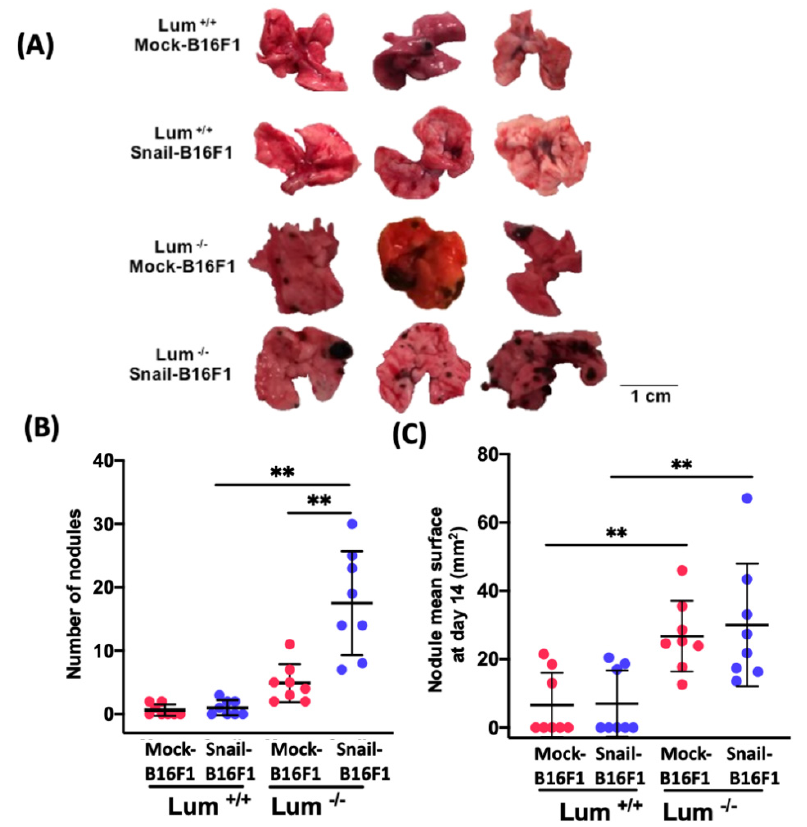
Figure 1. Study of lung metastatic nodules of melanoma cells in the wild-type and lumican-knockout C57BL/6J mice. ( A ) Lung metastatic nodules, observed at day 14, obtained after injection in the tail vein (n = 250.000 cells/mouse) of Mock-B16F1 and Snail-B16F1 (three representative pictures are shown from each group (n = 8) of Lum − / − and Lum +/+ ). Lung metastatic nodules are significantly more numerous in the Lum − / − in comparison with the Lum +/+ mice. ( B ) Number of metastatic nodules detected per mice at day 14. ( C ) Total mean surface of the nodules measured per section of lung tissue per mouse at day 14. Statistical differences at the level of p < 0.01 are given with asterisks (**).